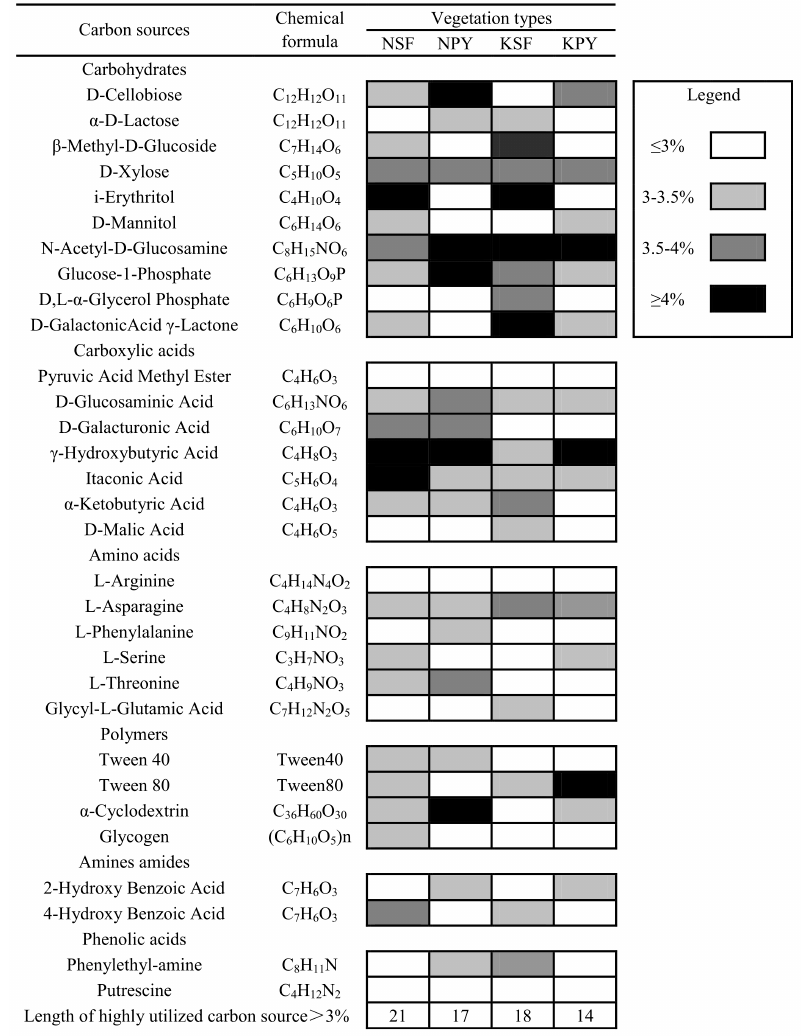
Figure 2. Use pattern of 31 carbon substrates by the microbial community under a Pinus yunnanensis plantation and a secondary forest in non-karst and karst areas in southern